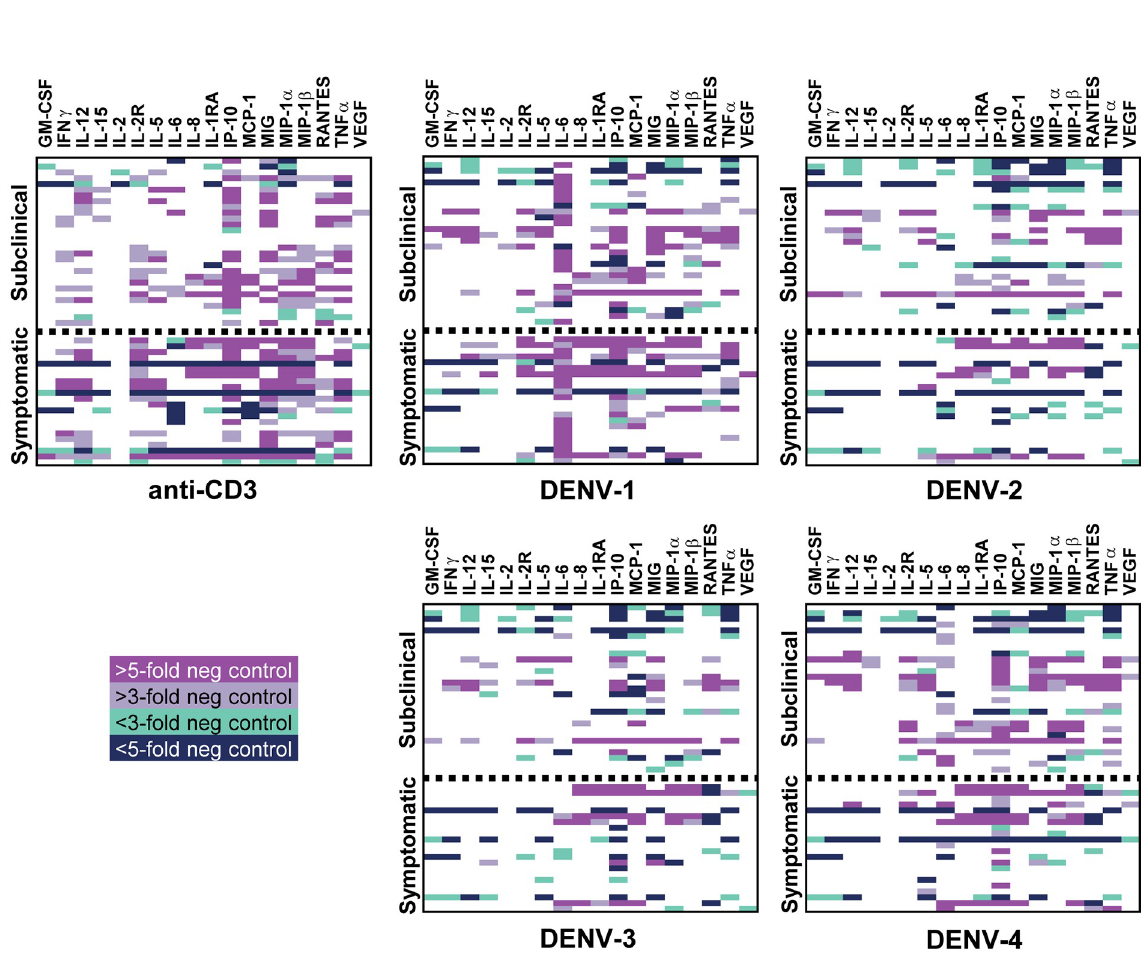
Fig 1. Relative expression of cytokines in cell culture supernatants from stimulated pre-illness PBMC. PBMC from subjects who went on to experience subclinical (n = 29) or symptomatic (n = 22) DENV infections were stimulated in vitro with anti-CD3 antibody (positive control), live DENV-1, live DENV-2, live DENV-3, live DENV-4, or uninfected Vero cell supernatant (negative control). After 6–7 days, culture supernatants were assessed by a multiplexed, bead-based array for quantification of 30 cytokines/chemokines/growth factors. Shown are three- and five-fold changes up (light and dark blue, respectively) or down (grey and pink, respectively), relative to the negative control, of each listed analyte. Each row represents responses from a single